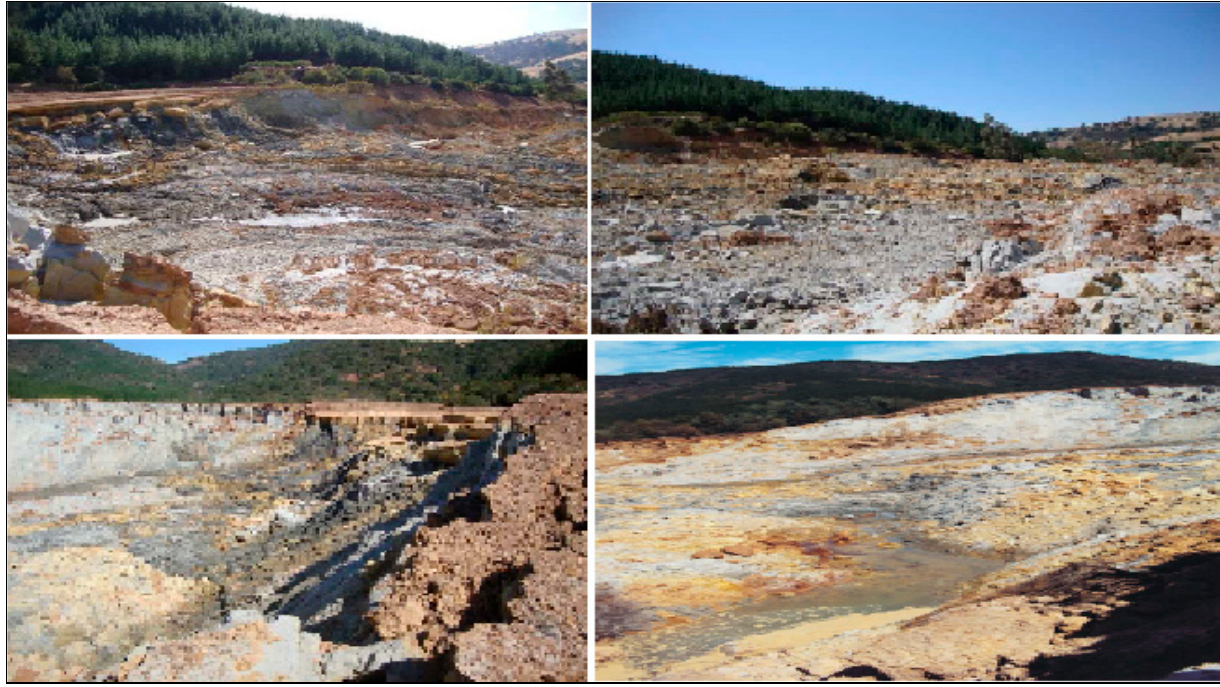
Figure 18. Collapsed area of the Las Palmas tailings deposit [66]. The most toxic form of CN is gaseous hydrocyanic acid (HCN). The upper threshold limit for HCN in the workplace was set by the North American Conference of Governmental Industrial Hygienists (ACGIH) at 4.7 ppm. At concentrations of 20–40 ppm HCN in air, some respiratory distress may be observed after several hours. Death occurs within a few minutes at HCN concentrations above about 250 ppm in air. For potassium or sodium cyanide, the lethal dose in humans by ingestion or inhalation varies between 0.050 and 0.2 g of cyanide, corresponding to about 3 grains of rice [69]. No HCN-affected people or animals were reported in the